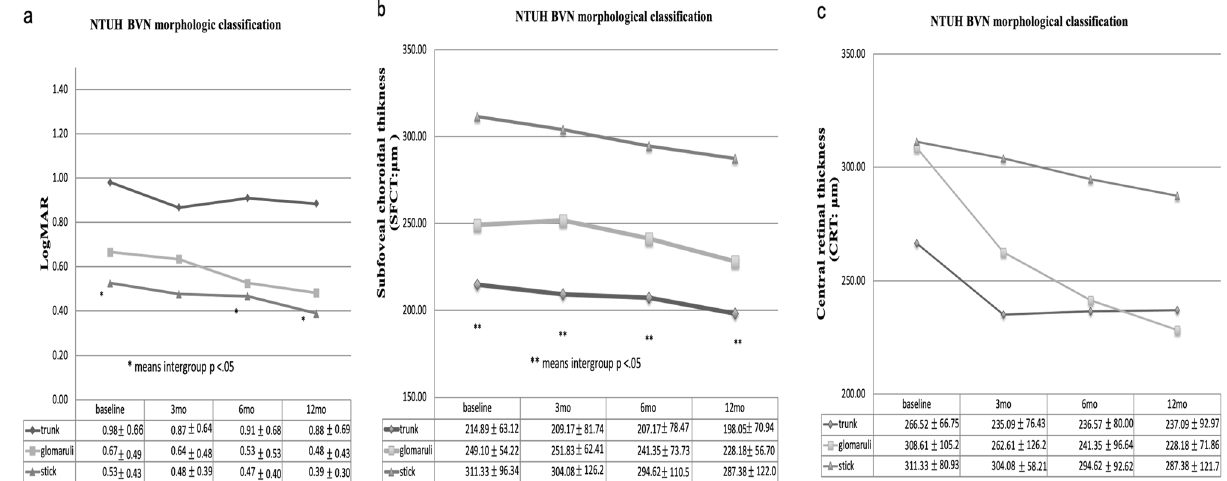
Figure 4. Comparison of changes in ( a ) BCVA in logMAR, ( b ) subfoveal choroidal thickness (SFCT), and ( c ) central retinal thickness (CRT) at different time points between the BVN types in PCV lesions: type 1: trunk form, type 2: glomeruli form, and type 3: stick form. The figure was depicted by EXCEL 2011 (Microsoft, Inc. Redmond, Washington, USA). BCVA best-corrected visual acuity, SFCT subfoveal choroidal thickness, CRT